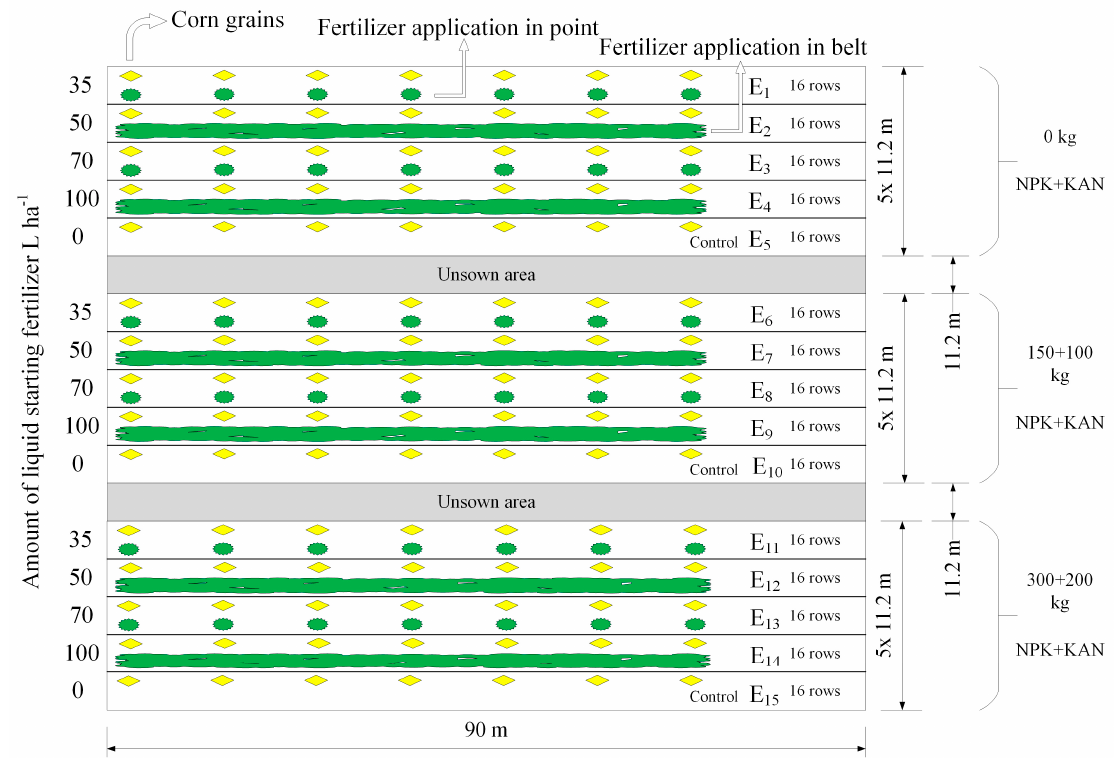
Figure 1. A scheme of the established trial.